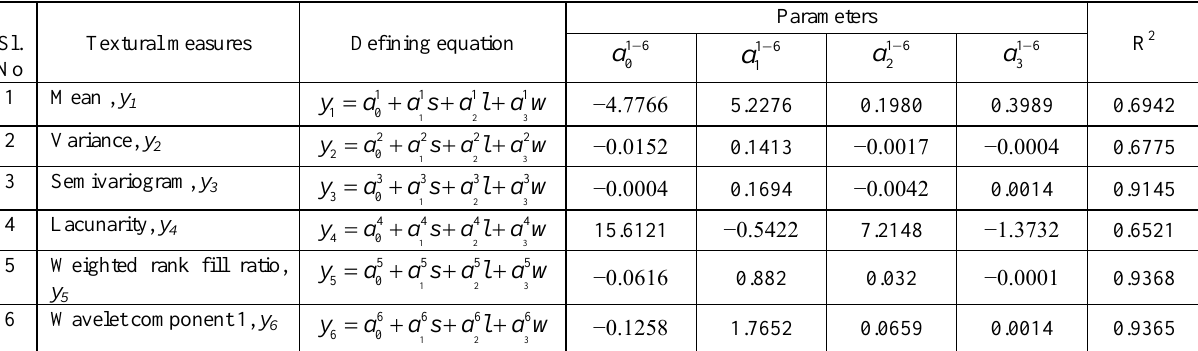
Table 1. Texture measures in terms of roughness parameters and window size.